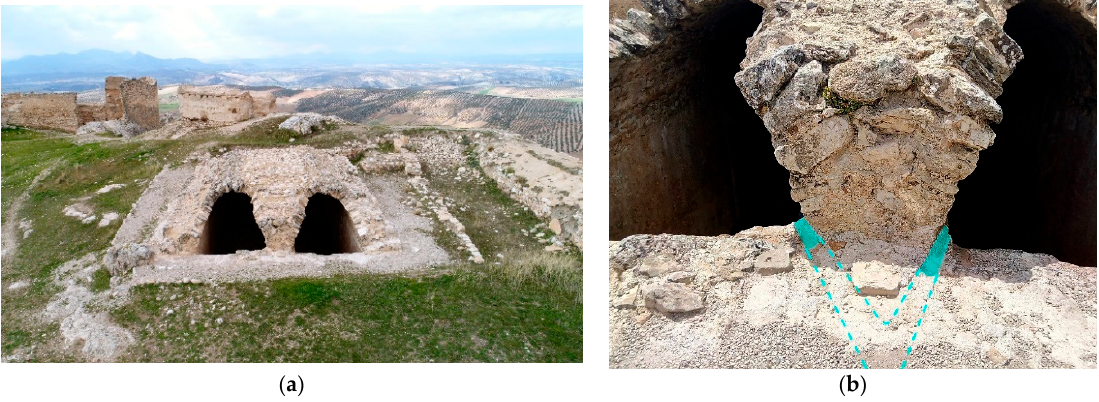
Figure 12. Cistern formed by two naves in the Alcazaba of Piñar. ( a ) View of the two naves cistern ( b ) Detail of the ceramic pipes at the joint of the vaults. Photographies by authors.